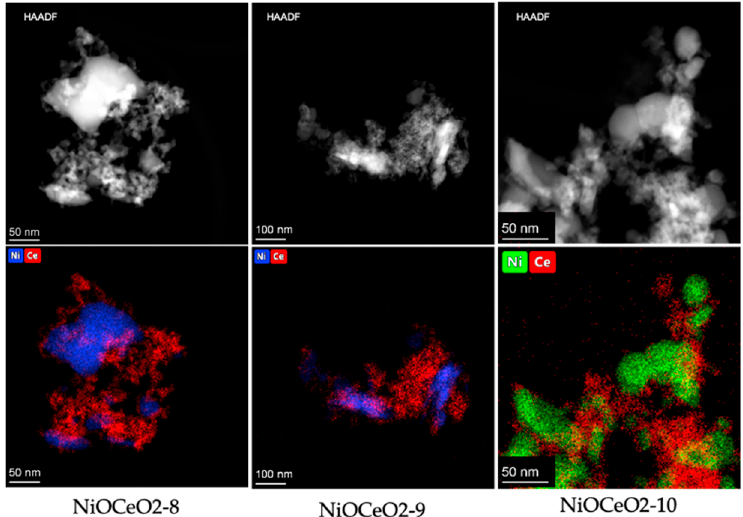
Figure 5. HAADF images and EDS mappings corresponding to the reduced NiOCeO 2 -8 ( left ), NiOCeO 2 -9 ( center ) and NiOCeO 2 -10 ( right ) catalysts.